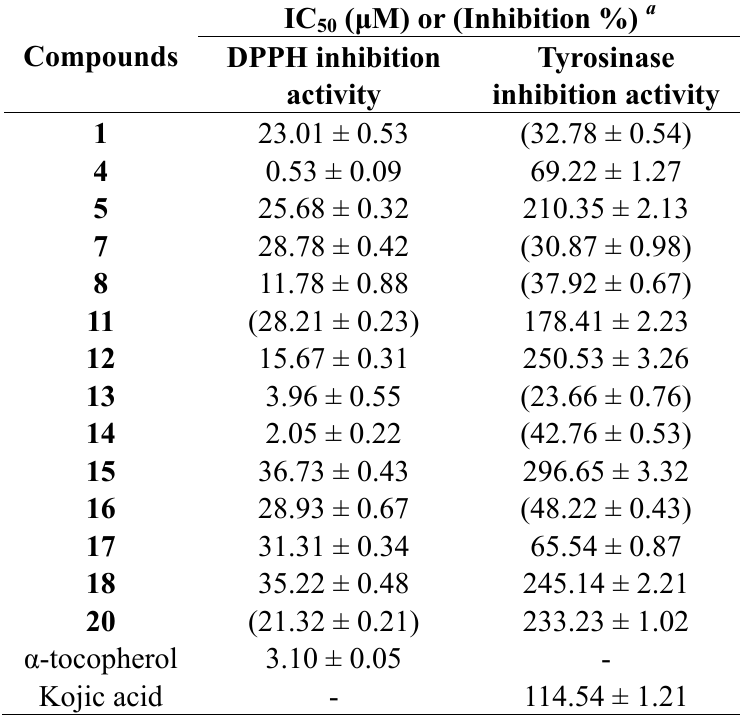
Table 2. DPPH inhibition activity and tyrosinase inhibition activity of compounds 1 , 4 , 5 , 7 , 8 , 11–18 , and 20